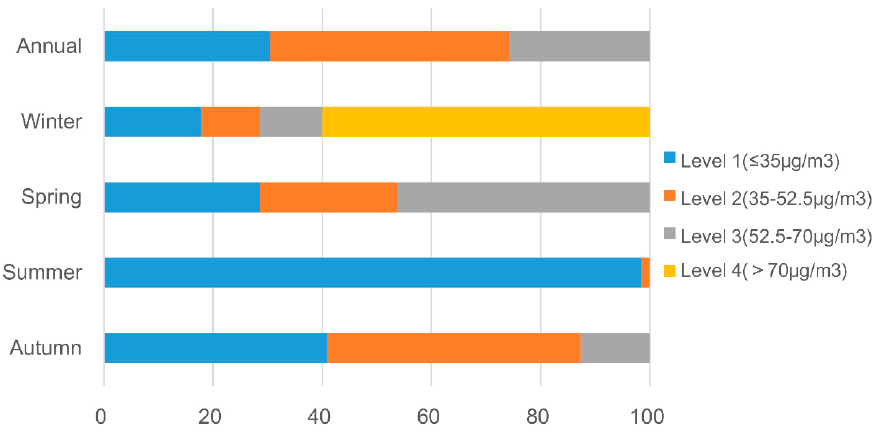
Figure 7. Area percentage of four levels in the whole year and four seasons.